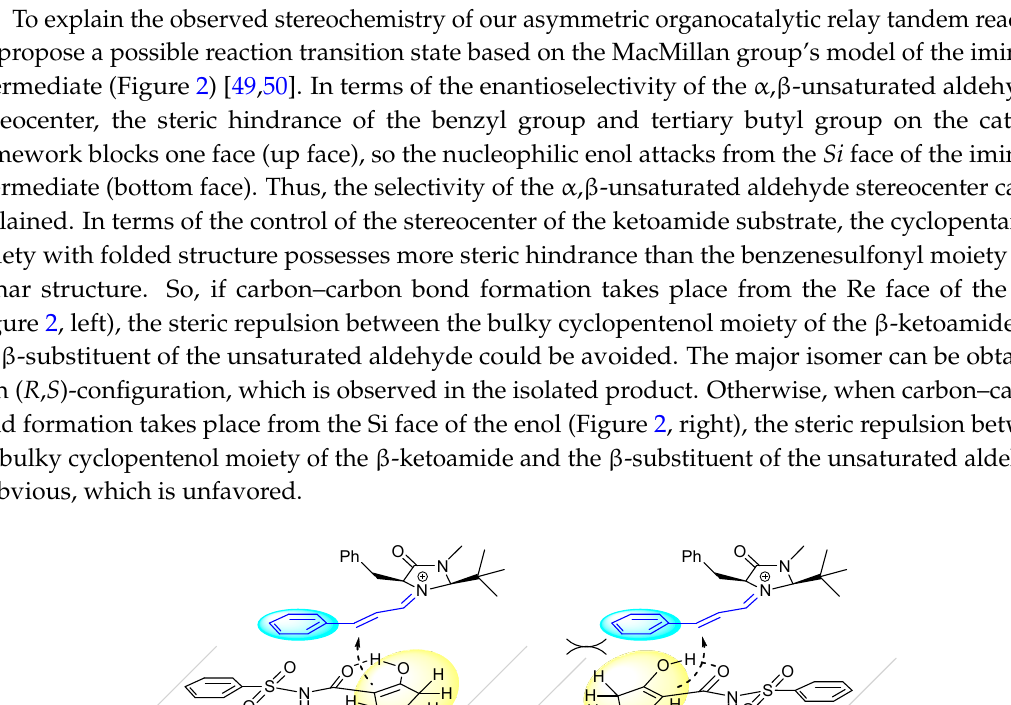
Figure 1. Oak Ridge Thermal Ellipsoid Plot (ORTEP) drawing of compound 5m .